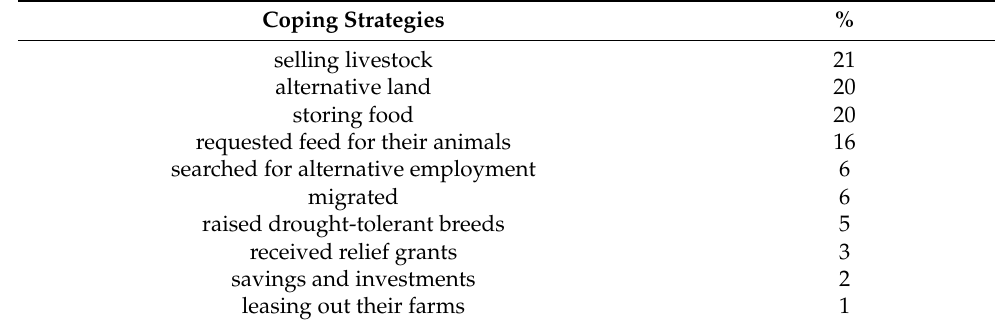
Table 3. Coping strategies adopted by smallholder livestock farmers in the Northern Cape Province of South Africa during a drought